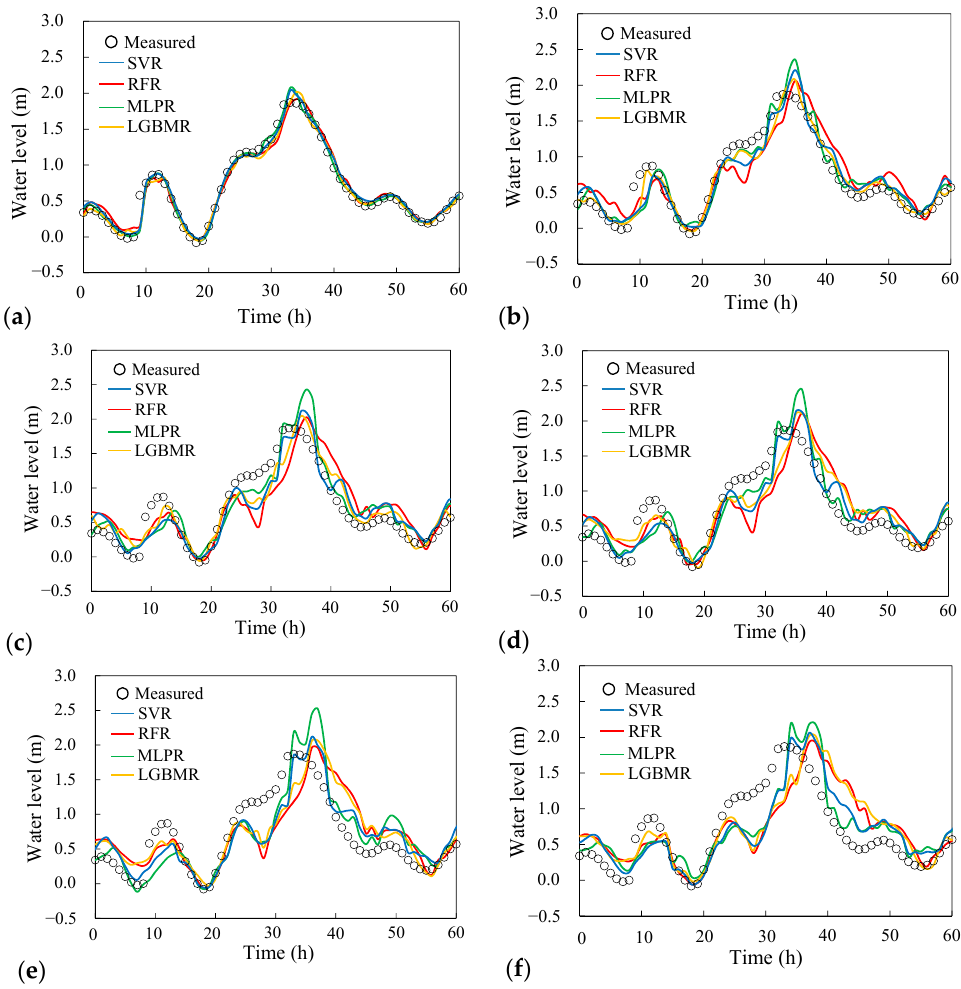
Figure 10. The comparison of measured and forecasted river stages at Kavalan station for Typhoon Soulik with ( a ) 1-, ( b ) 2-, ( c ) 3-, ( d ) 4-, ( e ) 5-, and ( f ) 6-h lead times.